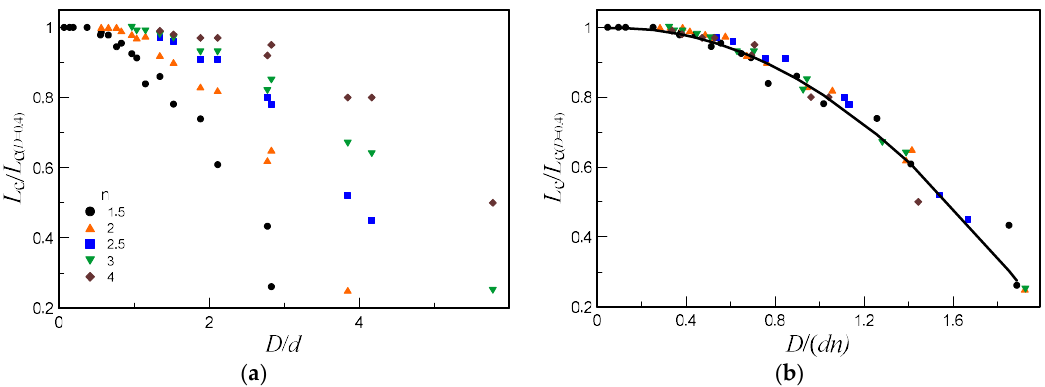
Figure 8. Normalized length of the supersonic core of the jet versus the ratio of the Pitot tube and nozzle diameters ( а ) and versus the ratio of the Pitot tube diameter D and nozzle diameter d multiplied by n ( b ).